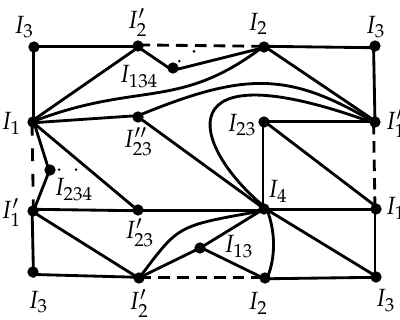
∪ 4 U n | = 6 with | U 1 | = | U 2 | = 2. n = 1 Figure 14. |